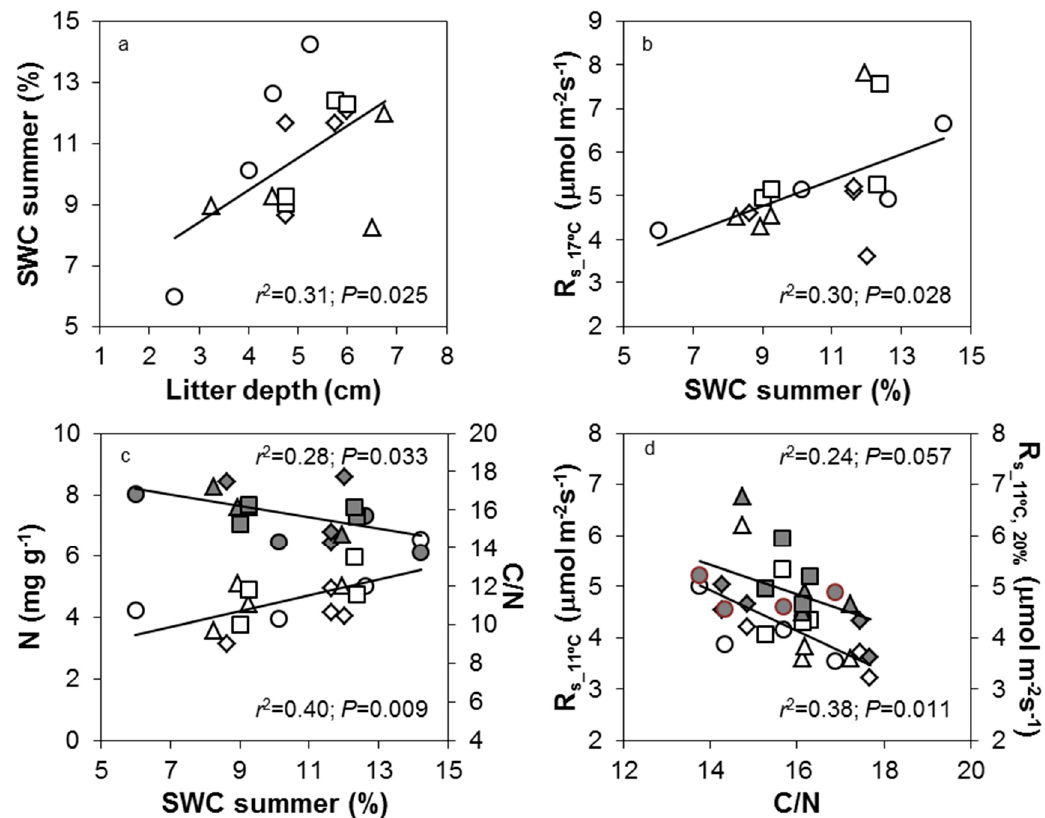
Figure 6. Relationships between soil variables across 16 plots established around centennial beech trees of di ff erent decline classes – vigorous (squares), a ff ected (diamonds), severely a ff ected (triangles) – and dead (circles): ( a ) Litter depth versus soil water content (SWC) during summer; ( b ) summer SWC versus standardized soil respiration ( R s ) during summer at 17 ◦ C (the average soil temperature ( T s ) during summer); ( c ) summer SWC versus soil nitrogen concentration (open symbols) and C to N ratio (C / N; closed symbols); and ( d ) C / N versus mean R s during the entire study period standardized at 11 ◦ C (the mean annual T s over the study period; open symbols) and at 11 ◦ C and 20% SWC (the mean annual SWC over the study period; closed symbols). The coe ffi cient of determination ( r 2 ) and p -value of linear regression models fitted to all tree-decline classes pooled are shown.